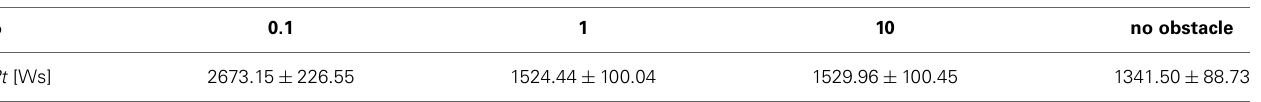
Table 1 | Average electric energy consumption for climbing trials using three different weight factors and walking without an obstacle in the